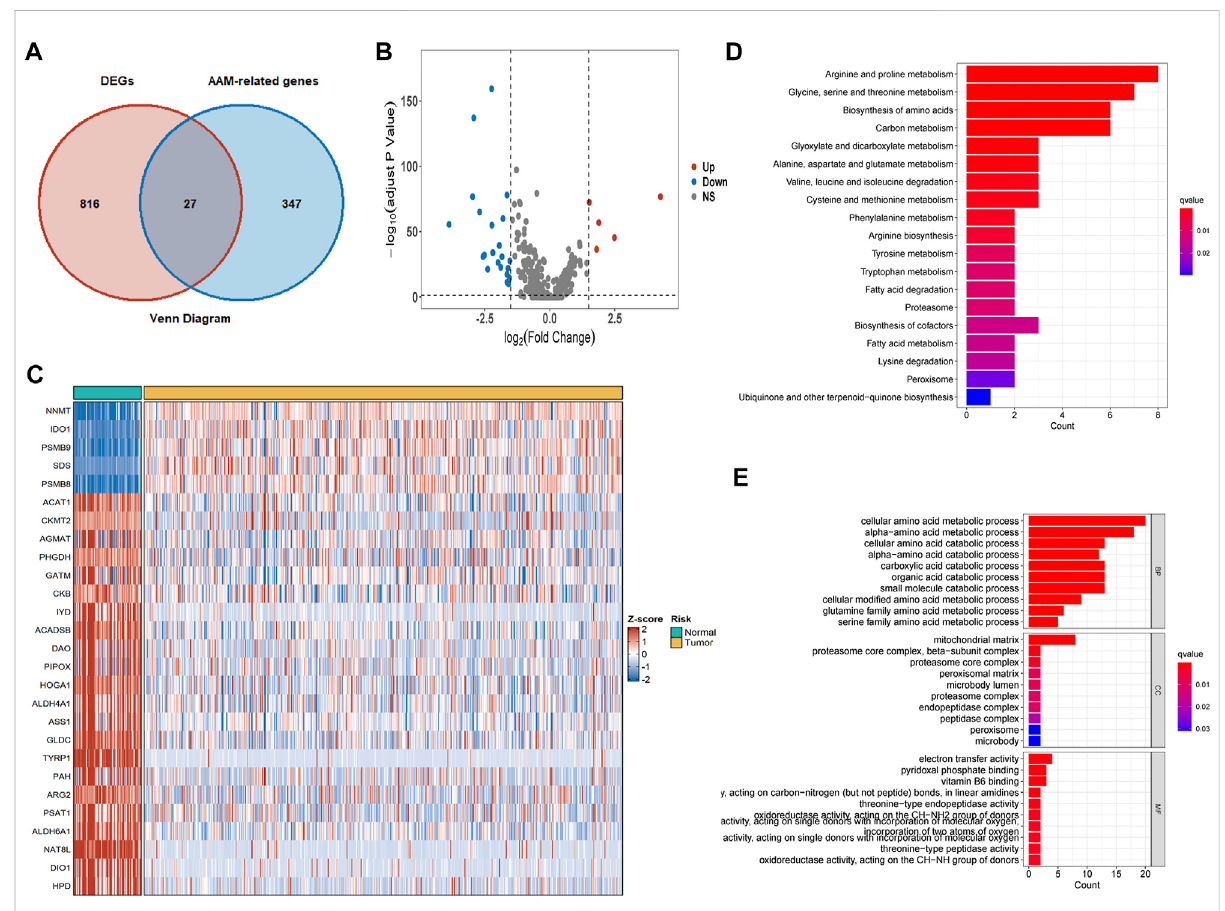
FIGURE 2 AAM-related DEGs in TCGA-KIRC cohorts and functional enrichment analysis. (A) Venn plots of co-expression gene between DEGs and AAM- relatedgene (B) VolcanoplotsofAAM-relatedDEGs; (C) HeatmapplotsofAAM-relatedDEGs; (D) KEGGanalysis; (E) GOanalysisinvolvingbiological process, cellular component, and molecular